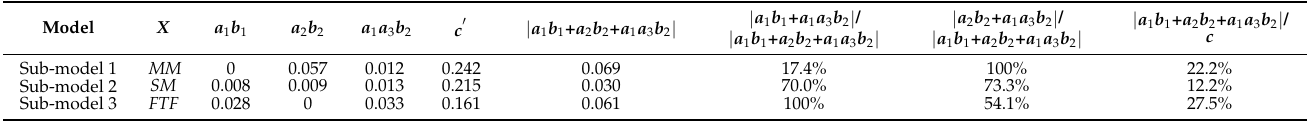
Table 6. Mediation effect analysis of sub-models